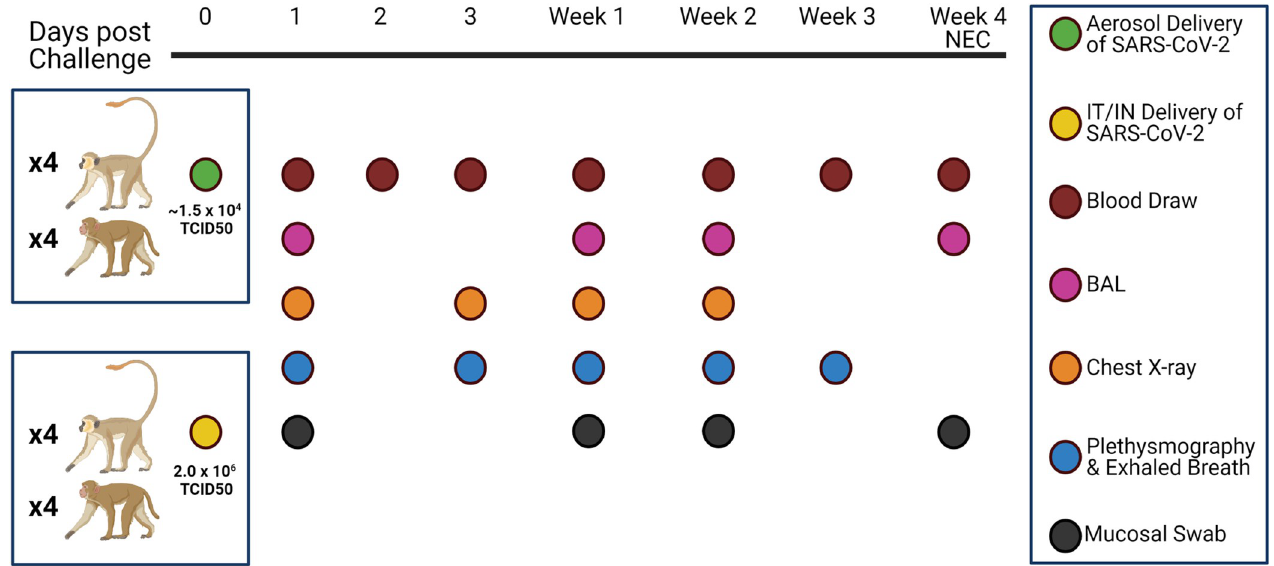
Fig 1. Study Design. SARS-CoV-2 was delivered via aerosol or IT/IN (multiroute) to RMs or AGMs at the noted doses. Animals were followed for 4 weeks, with biosampling performed as indicated above. Fig created in Biorender.com.